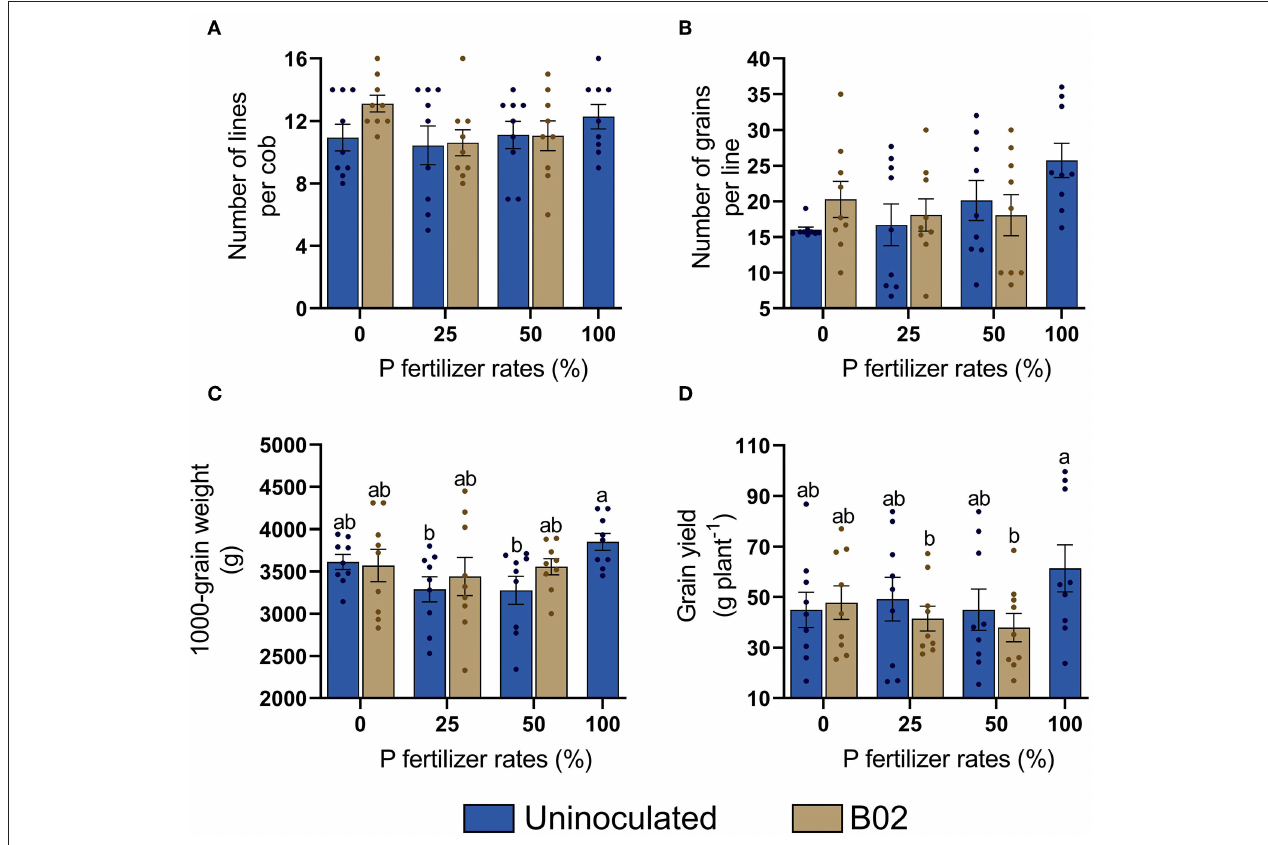
FIGURE 7 | Influence of inoculation with Rhizobium sp. B02 on the number of lines per cob (A) , number of grains per line (B) , 1,000-grain weight (C) , and grain yield (D) of the yellow endosperm genotype of maize at the reproductive stage of physiological maturity. Means and standard errors result from three replicates and three independent repetitions. Different letters are indicators of significant differences according to Tukey’s test ( p <